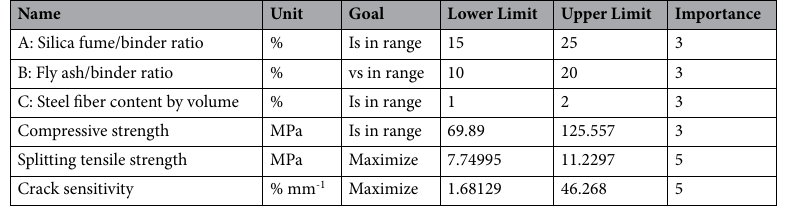
Table 6. Optimized standard Settings.